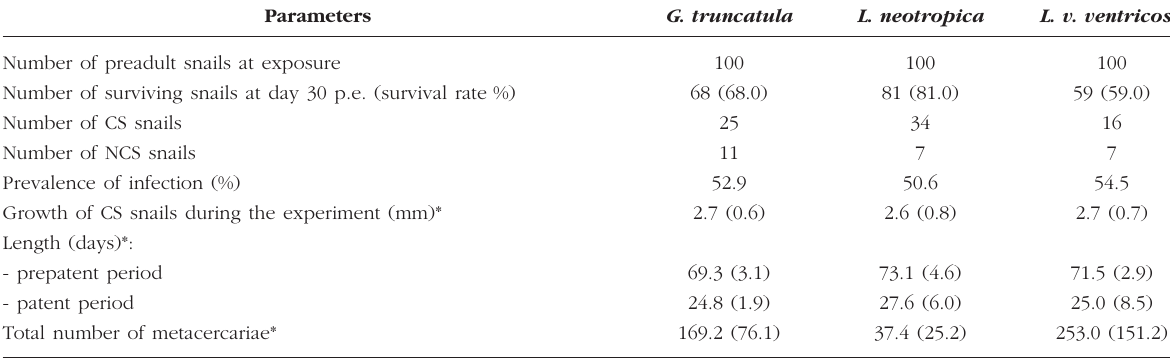
Table I. – Main characteristics of P. daubneyi infection in three species of lymnaeid snails (experiment